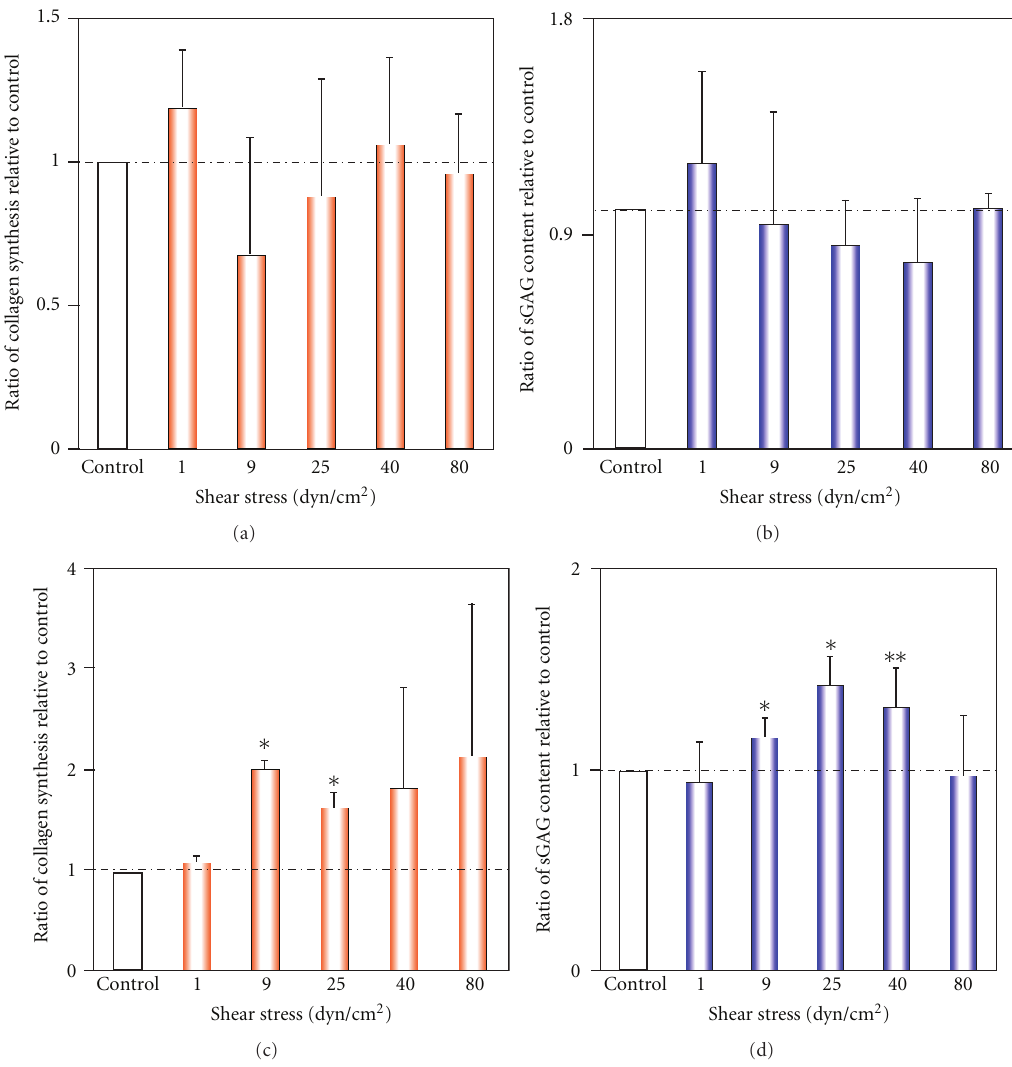
Figure 3: E ff ects of steady shear stress on aortic valve biology. Collagen synthesis and sulfated glycosaminoglycan content in intact (a and b, resp.) and denuded (c and d, resp.) aortic valve leaflets under steady shear